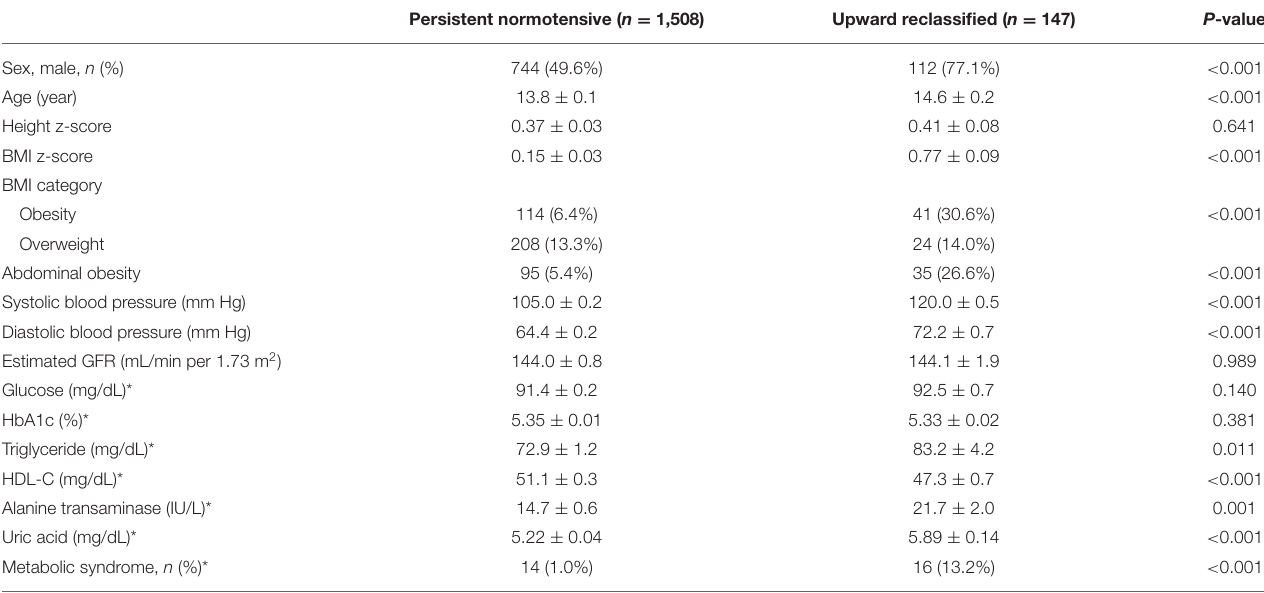
TABLE 4 | Comparison between subjects with normal blood pressure by ESH 2016 criteria. Persistent normotensive ( n =